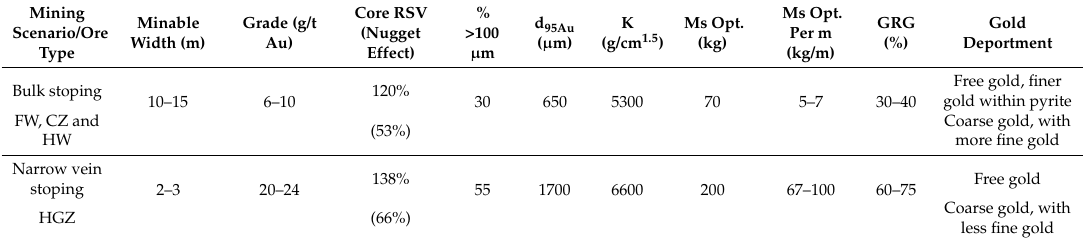
Table 27. Comparison between bulk-mine ore zone and selective narrow-vein ore